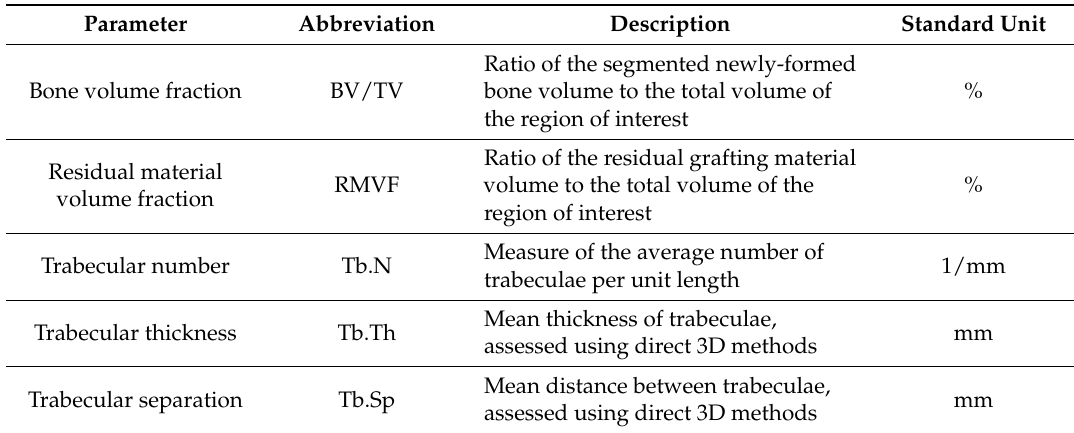
Table 1. Parameters assessed by analysis of the micro-computed tomography (CT)